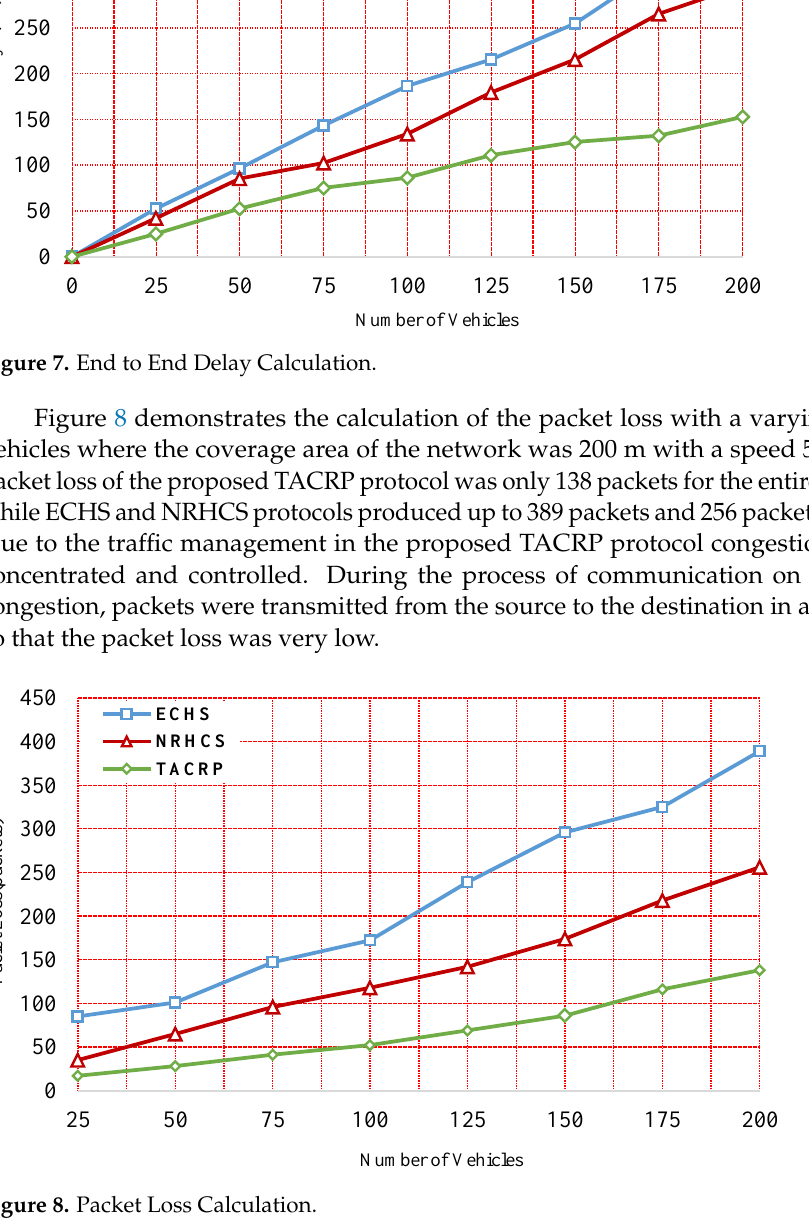
Figure 8. Packet Loss Calculation.